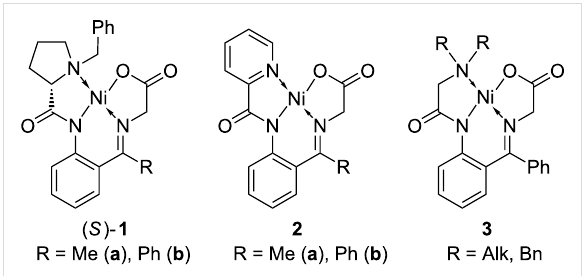
Figure 1: A family of chiral and achiral equivalents of nucleophilic glycine.